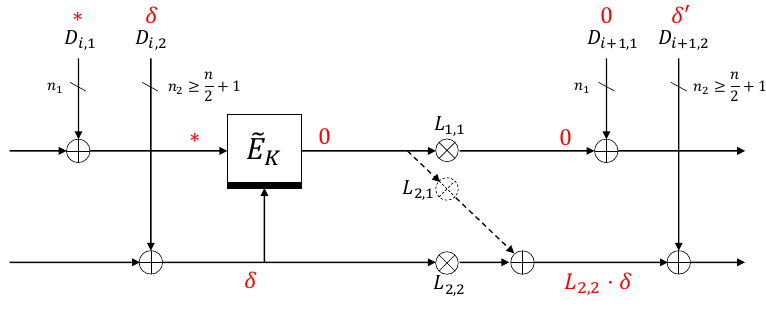
Figure 8: Differential Propagation for Case 2 with L 1 , 2 =